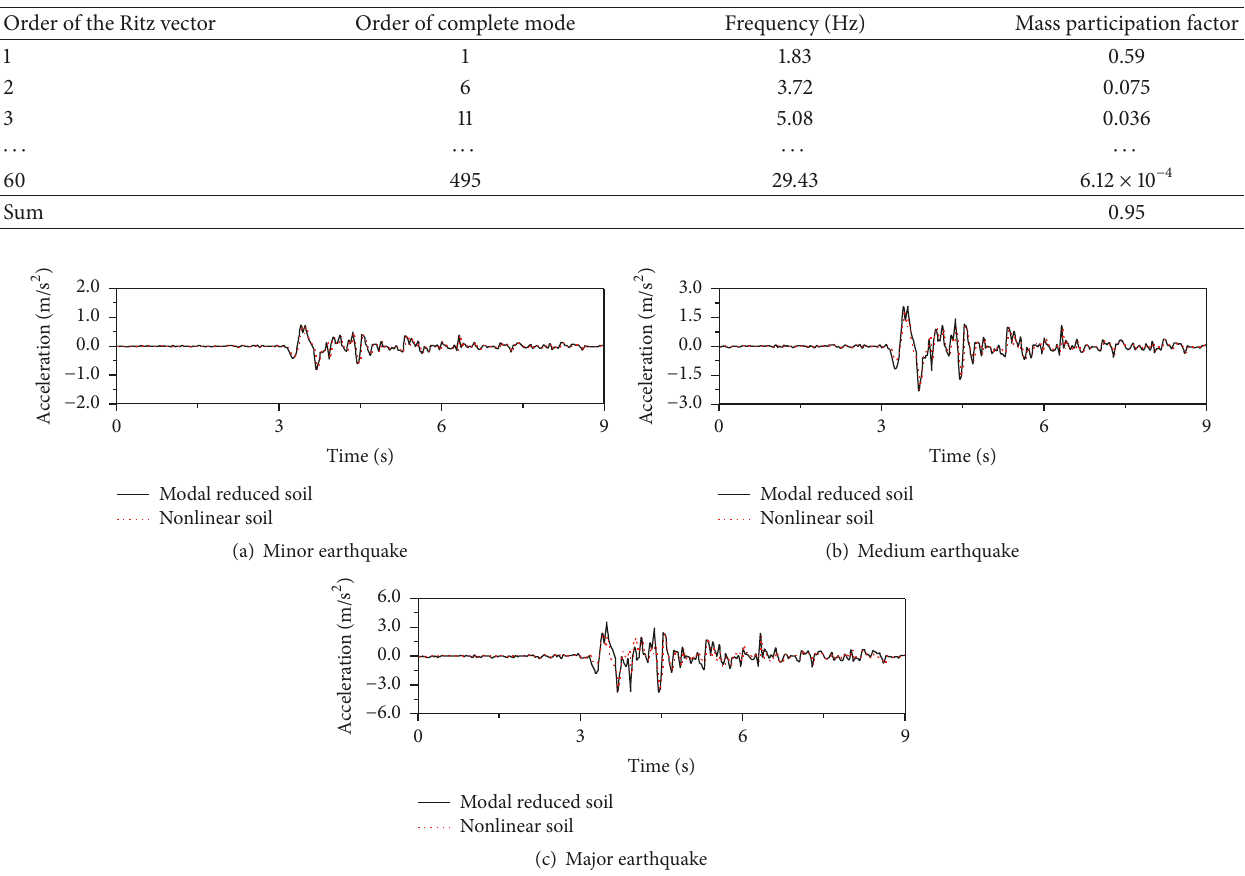
and the mass of fourth story, 𝑚 4 , was 1,540 kg. Based on this, the stiffness ( 𝑘 ) and damping coefficients ( 𝑐 ) of these stories were calculated: the 1st story: 𝑘 1 = 2,423,080 N/m, = 4,463 N/(m/s); the 2–4th stories: 𝑘 𝑐 1 3,833,120 N/m, 𝑐 2 = 𝑐 3 = 𝑐 4 = 7,061 N/(m/s). The mass, follows: 𝑚 5 = 90 kg, 𝑘 5 = 93,046 N/m, and 𝑐 5 = 42